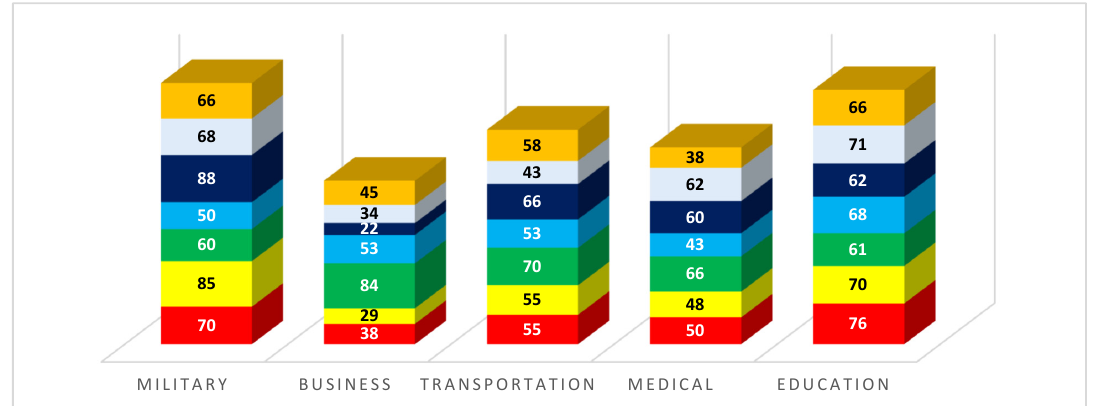
Figure 13. Results of various fields, calculated in an index, before 6G.